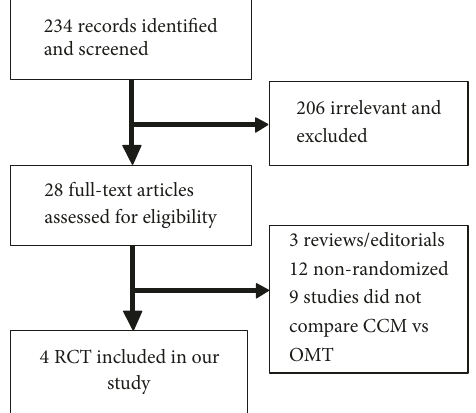
Figure 1: A flow diagram of the search strategy conducted. A flow diagram of the search strategy conducted. The purpose of this figure is to provide a graphical representation of the manner in which we conducted our search for RCT for CCM. PRISMA guidelines were